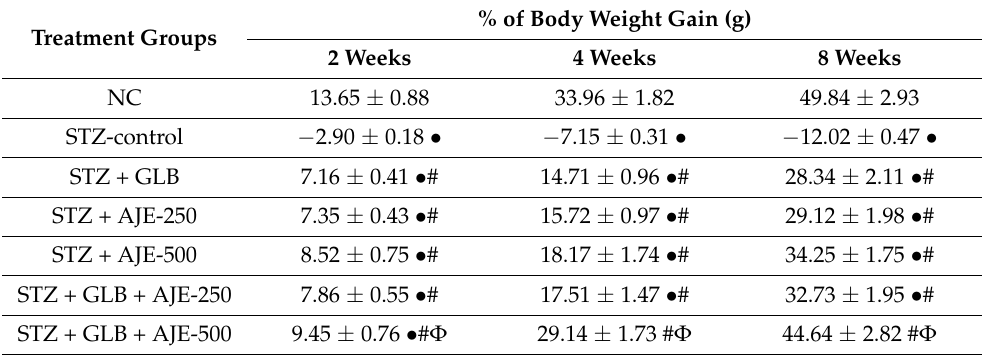
Table 2. Effect of GLB, AJE, and their combination on body weights of STZ-diabetic rats. Treatment Groups